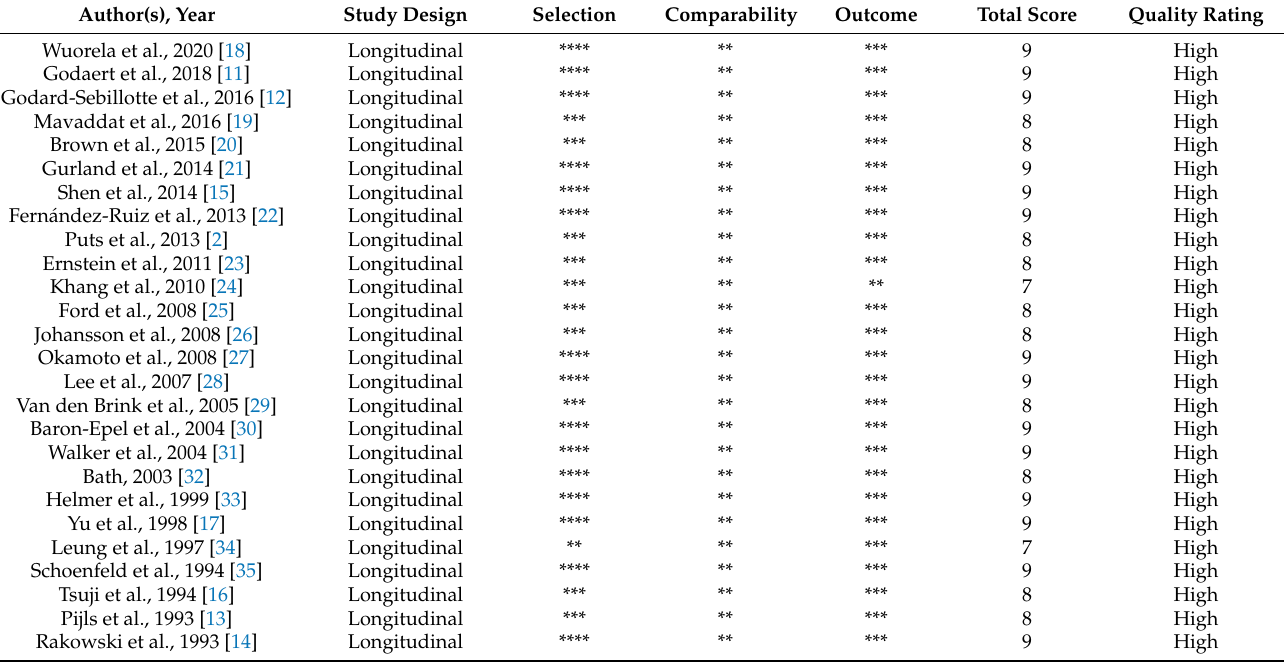
Table 3. The quality was considered high for all 26 studies. Table 3. Quality assessment of the different studies included in this systematic review performed using the Newcastle–Ottawa scale